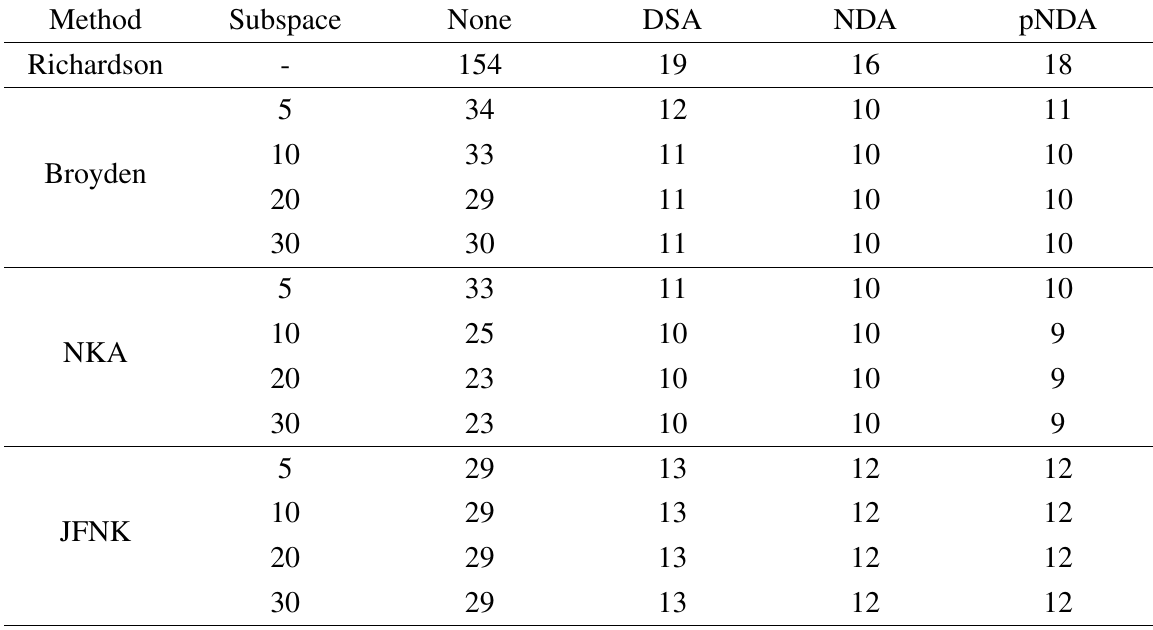
Table 1: Number of sweeps needed for SBA-AWDD for the 2D Shielding Problem.